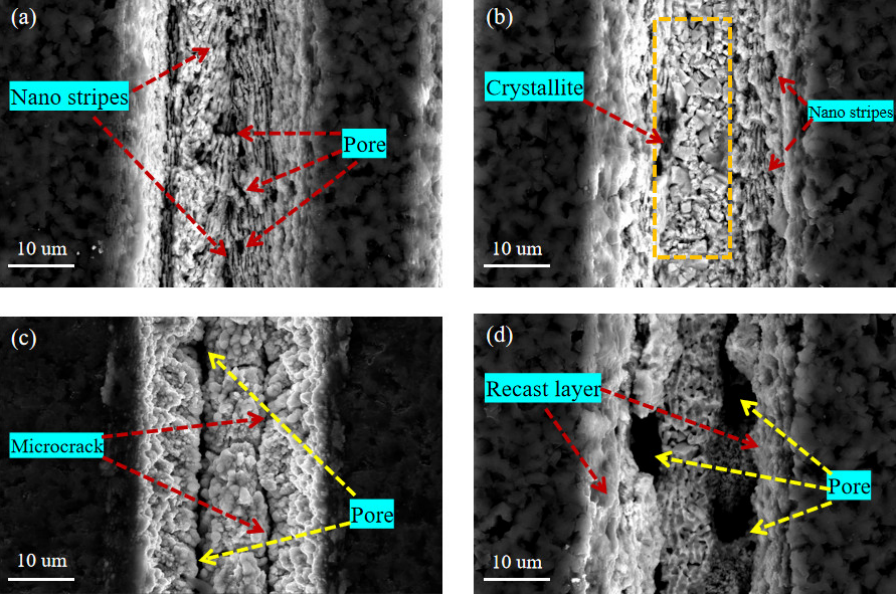
Figure 11. SEM image of micro-texture surface morphology under different scanning times. ( a ) = 1, ( b ) = 3, ( c ) = 5, ( d ) = 8. ( b ) = 3, ( c ) = 5, ( d ) =